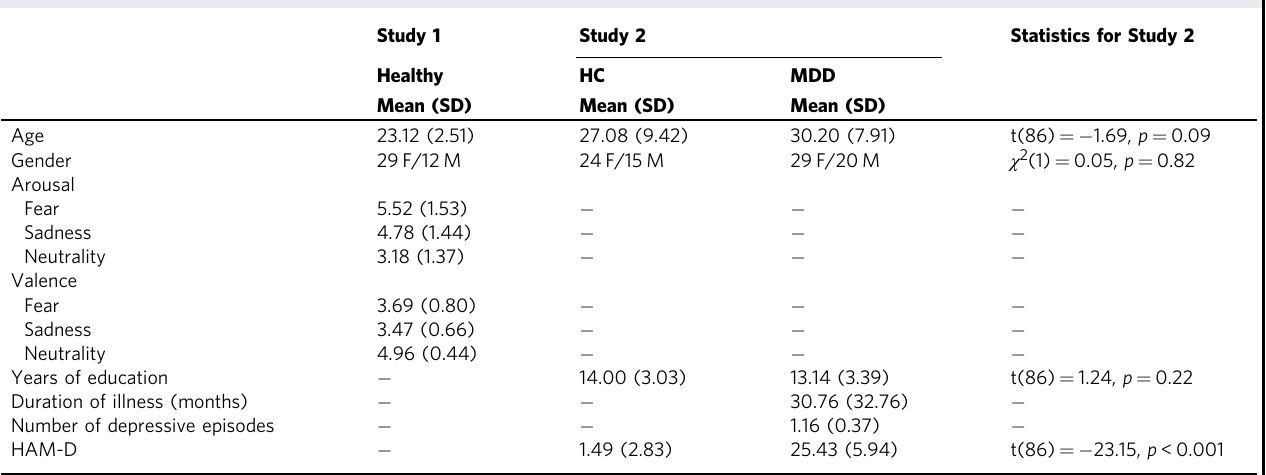
Table 1 Demographics and clinical information for Studies 1 and